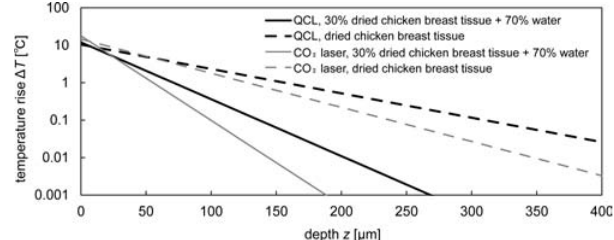
Fig. 9. Temperature rise (cid:1) T as function of depth z in sample for F 0 ¼ 125 mJ/cm 2